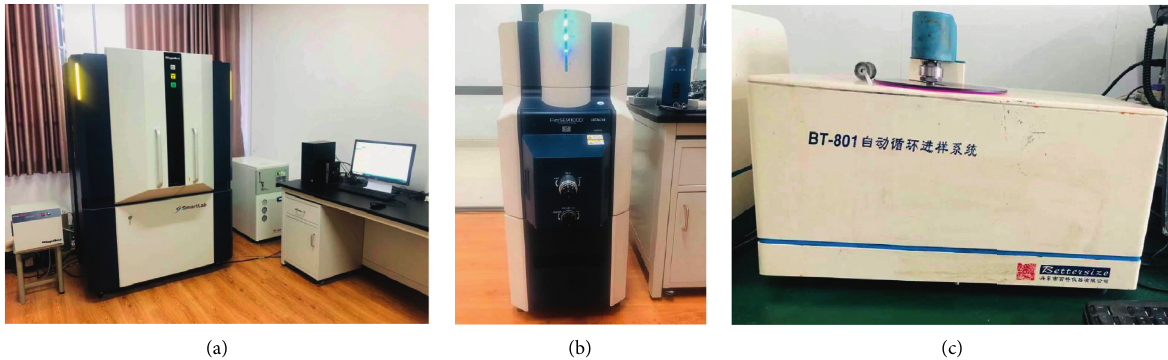
Figure 3: Microstructure and composition analysis instrument. (a) X-ray diffractometer. (b) SEM. (c) Laser particle size analyzer.